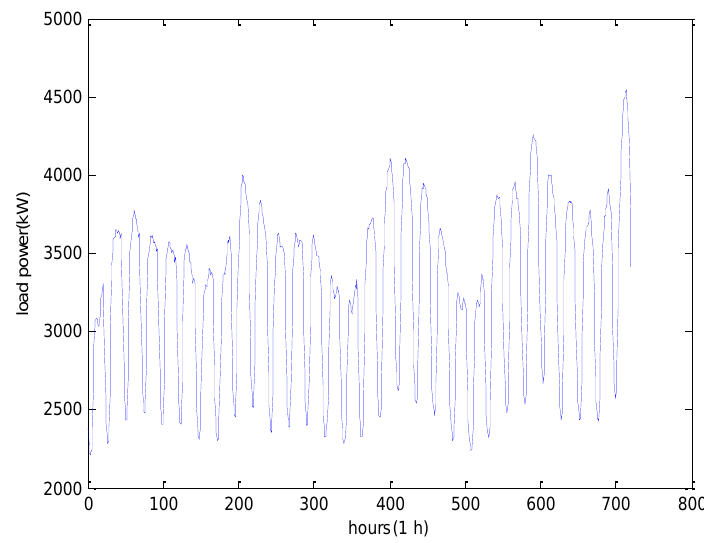
Figure 5. Illustration of the load power in June 2014.